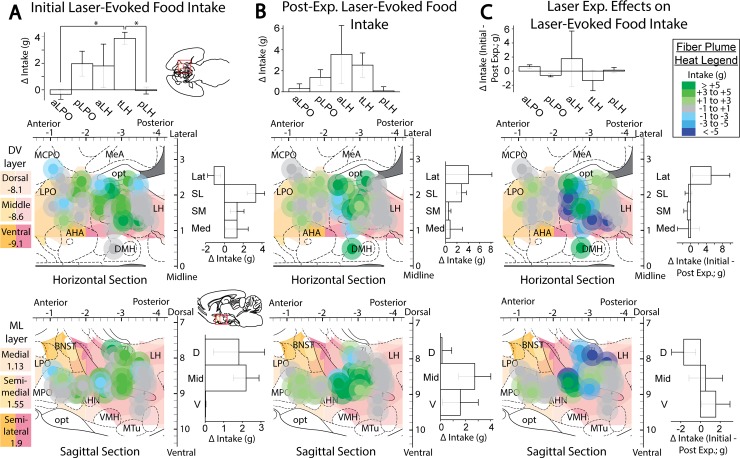
Anatomical localization of laser-mediated food intake.Fos plume placement maps demonstrating laser effects on food intake in ChR2 subjects prior to (A), after (B), and magnitude of change due to (C) extended laser exposure. Plume locations are mapped onto horizontal and sagittal portions of stereotaxic atlas pages (29). Each dot represents one subject’s unilateral Fos plume scaled to estimated size of 200+% of baseline expression, and color represents magnitude of eating response (defined as the individual’s intake difference between laser and no laser conditions). Bilateral placements are both overlaid onto the same unilateral diagram. Bar graphs represent intake difference scores (defined as group’s average laser session intake minus average non-laser session intake, assessed separately for different anatomical levels). Bar graphs depict change in intake in grams, calculated as intake under laser stimulation minus intake without laser stimulation in panels A and B, and then post-experience change in intake minus pre-experience change in intake in panel C. Brain area abbreviations: AHA—anterior hypothalamic area; BNST–bed nucleus of stria terminalis; DMH–dorsomedial hypothalamus, HDB–horizontal diagonal band of Broca; LH–lateral hypothalamus; LPO–lateral preoptic area; MCPO–magnocellular preoptic area; MeA–medial amygdala; opt–optic tract; VP–ventral pallidum; ZI–zona incerta. Bar graph labels: Lat–lateral; SL–semi-lateral; SM–semi-medial; Med–medial; D–dorsal; Mid–middle; V–ventral. *: p < 0.05, **: p < 0.01.